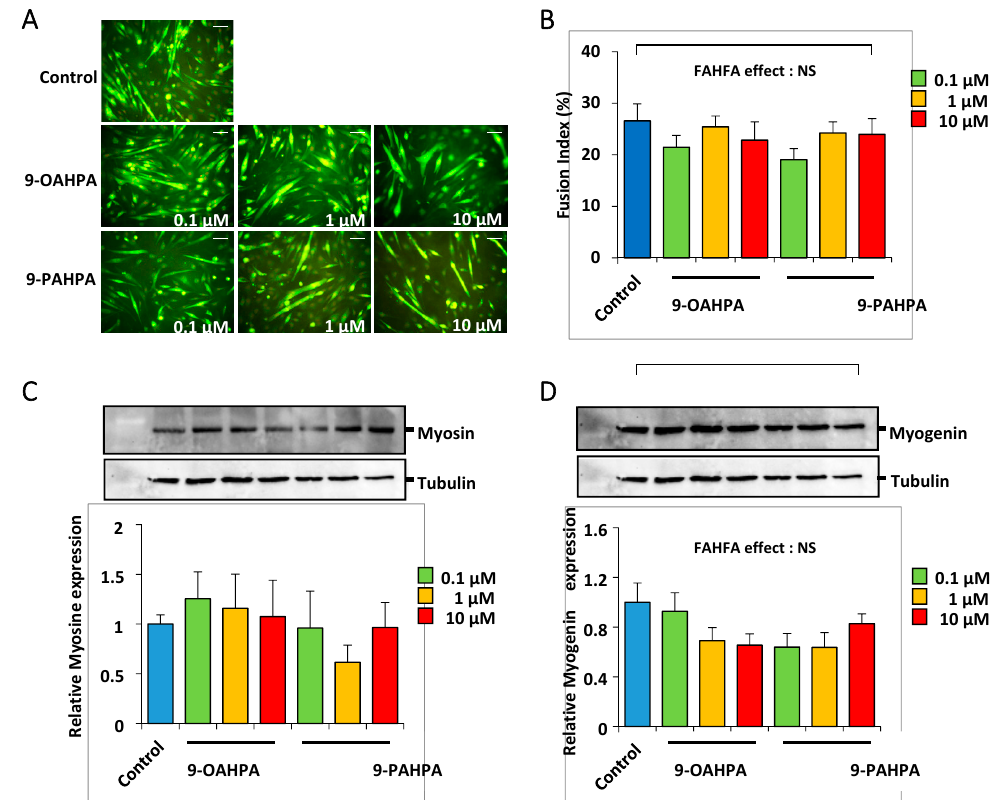
Figure 5. Influence of 9-OAHPA and 9-PAHPA on C2C12 myoblast di ff erentiation. ( A ) Cytoimmunofluorescence studies using antibodies raised against Troponin T were performed on C2C12 myoblasts after 5 days in di ff erentiation medium. FAHFAs were added at the induction of the di ff erentiation at the indicated concentration ( n = 6 for each group). Scale bar, 200 µ m. ( B ) The extent of di ff erentiation was assessed by the fusion index (percentage of nuclei incorporated into myotubes relative to the total number of nuclei). ( C , D ) Total MyHC and myogenin protein levels were analyzed by Western blot ( n = 6 for each group). Typical blots are shown. Proteins were quantified with Image Lab ™ Touch Software. There is no statistical di ff erence (one-way ANOVA, followed-up by an LSD test). Results are expressed as means ±